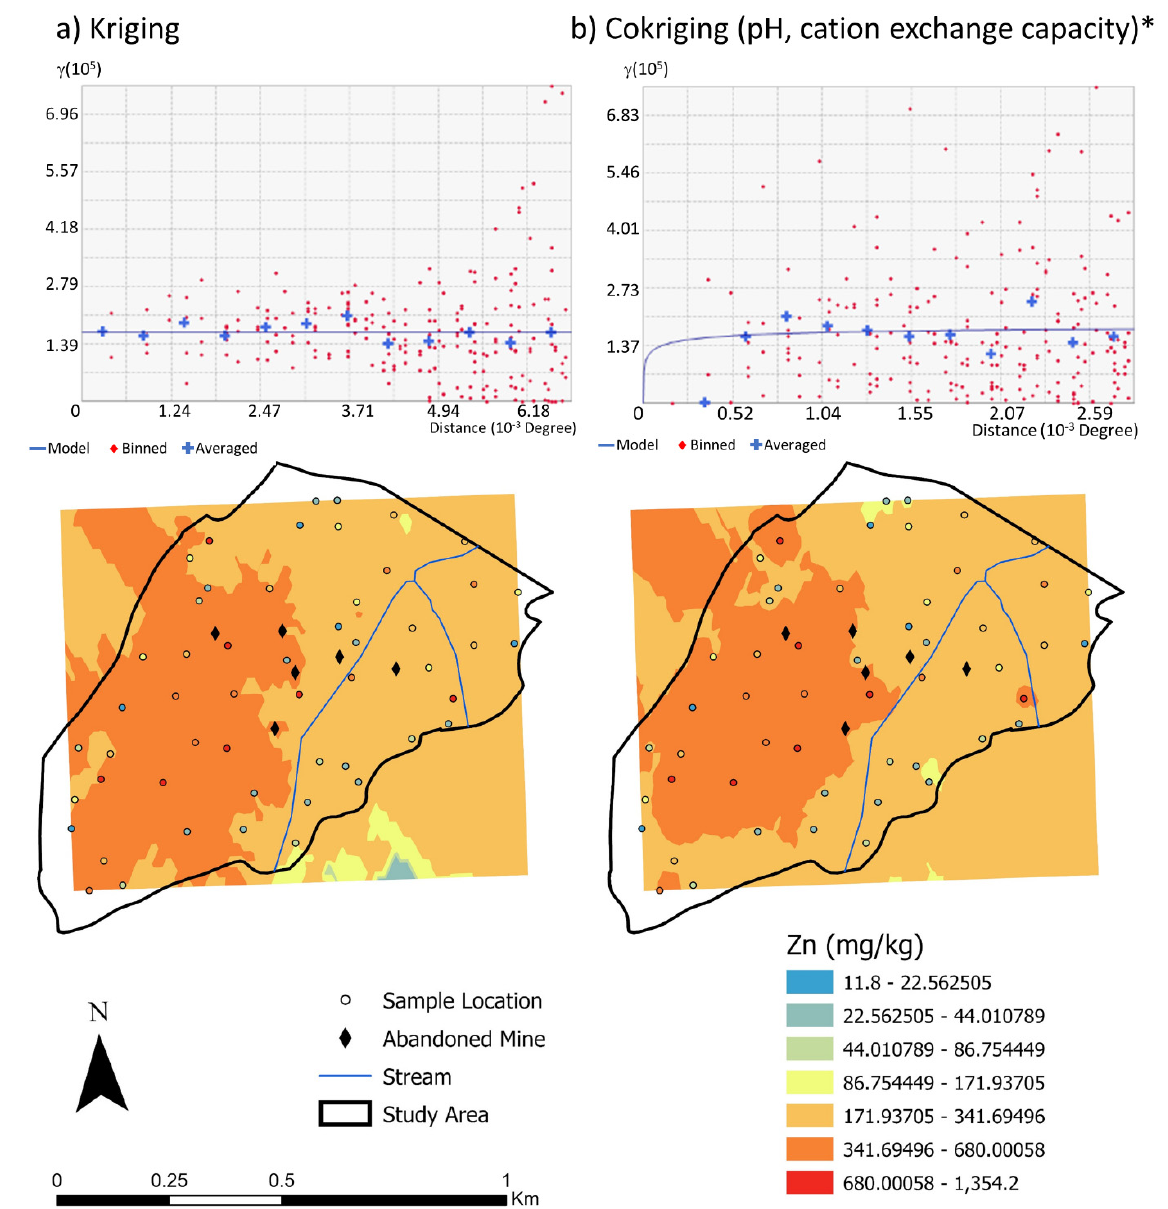
Figure 4. Variograms and interpolated Zn concentration using ordinary kriging ( a ) and cokriging ( b ). Cokriging model, marked with an asterisk, was selected as the superior model.